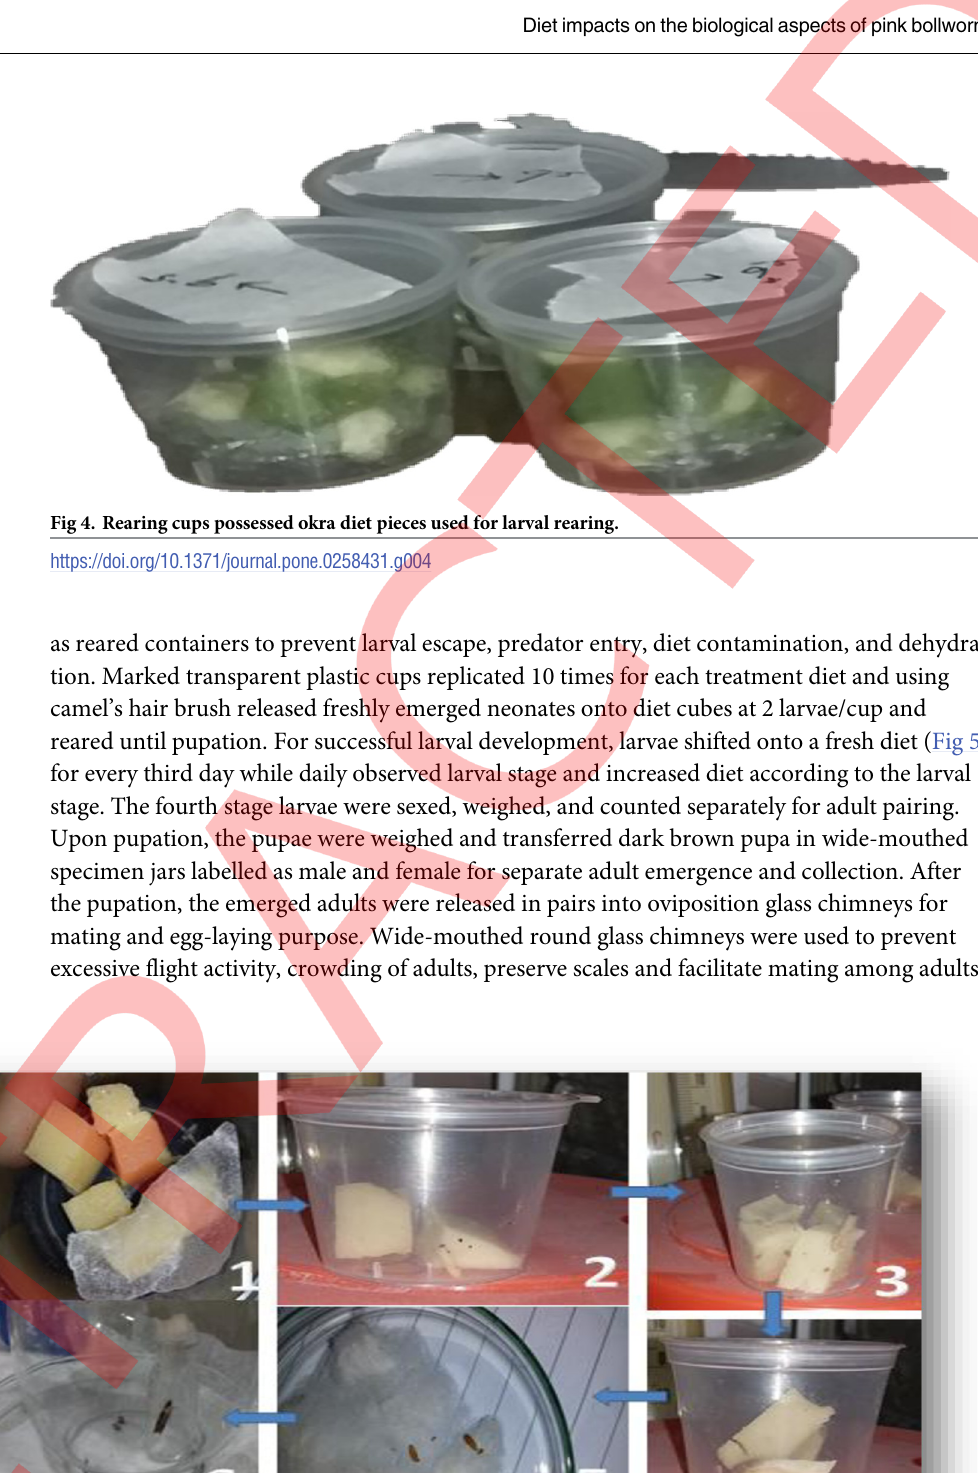
Fig 5. 1: Neonate larva shifted on diet 2: Second instar larva feed on prepared diet 3: Third instar 4: Fully grown fourth instar ready to pre-pupate 5: Male and female dark brown pupae 6: Emerged pink bollworm adult.